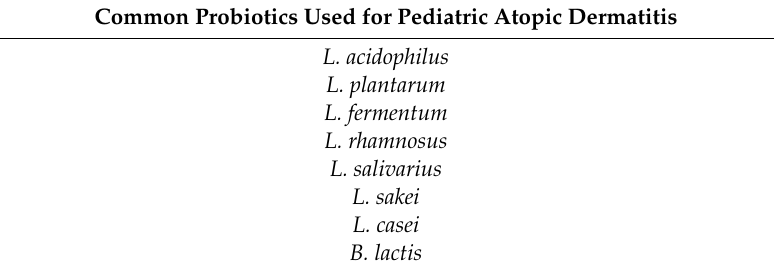
Table 2. Common probiotics used in treating pediatric atopic dermatitis. Common Probiotics Used for Pediatric Atopic